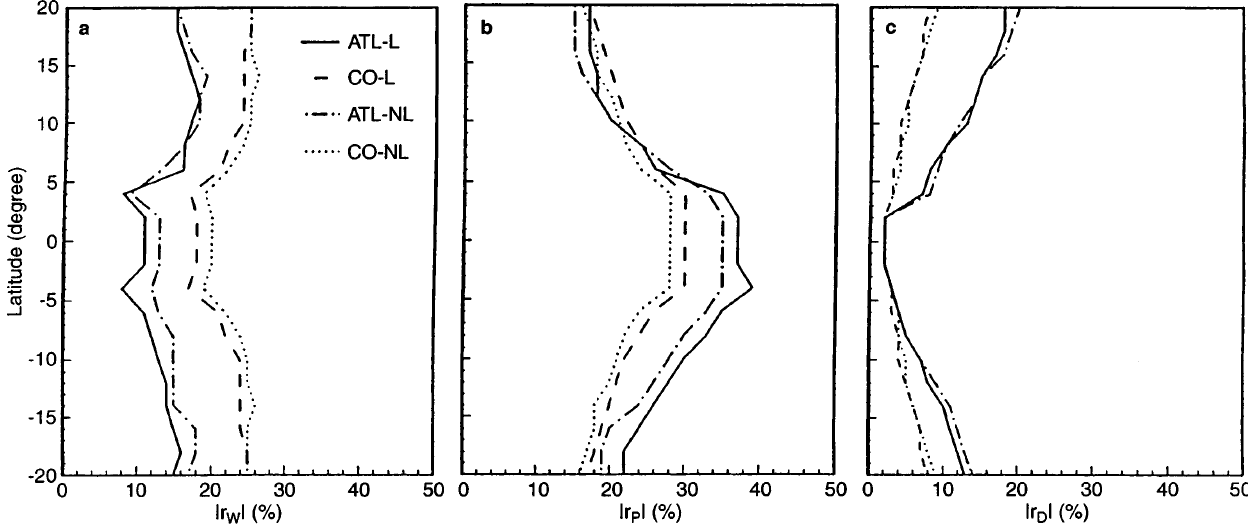
Fig. 6a–c. Energy flux coe(cid:129)cient (%) at di(cid:128)erent latitudes (degree). a r , b r and c r . Solid line : linear experiment with Atlantic coastline W P D ( ATL-L ). Dashed line : linear experiment with meridional coastline